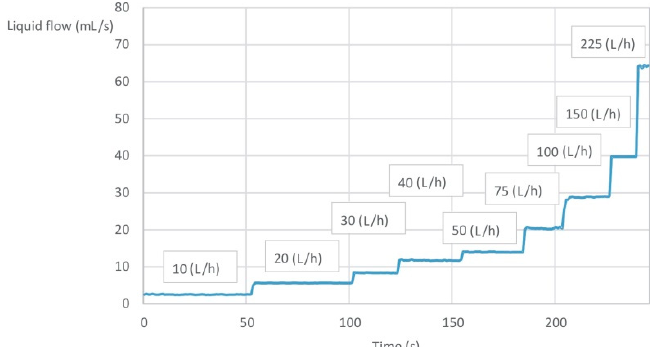
Figure 13. The exemplary dependence of the liquid flow rate values read on the rotameters (boxes) and the PLC meter (curve) on the time.